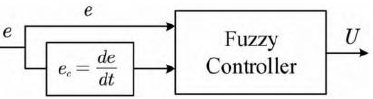
Figure 9. Structure of two-dimensional fuzzy controller.